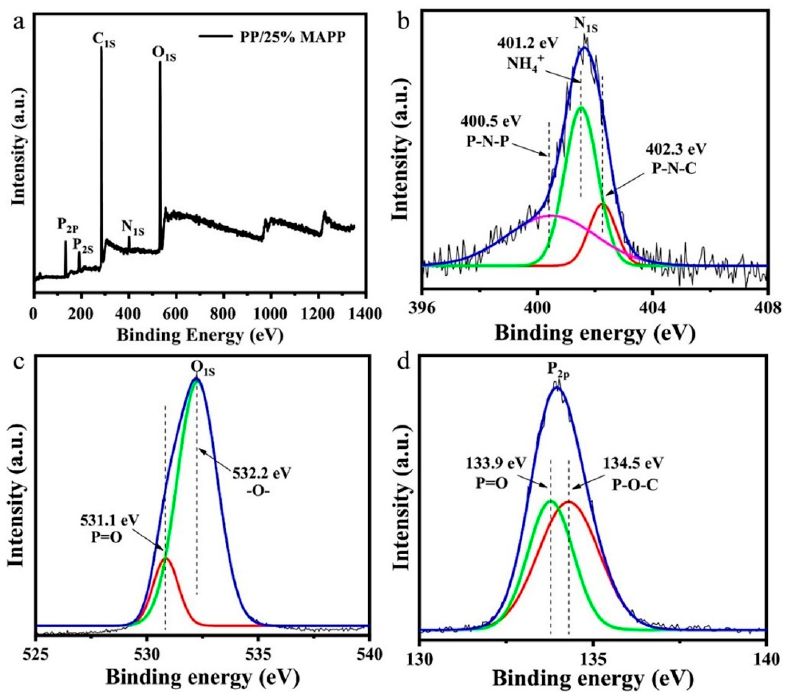
Figure 10. The wide-scan ( a ), N 1S ( b ), O 1S ( c ), and P 2P ( d ) XPS spectra of char residue of PP/25%MAPP after CCT. after